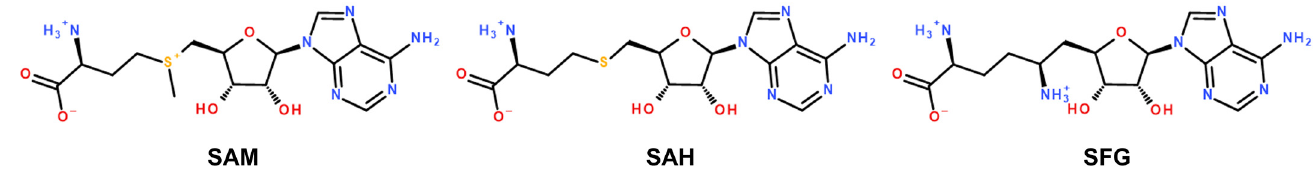
Figure 1. Molecular structures of the DNMT2 and NSUN6 cofactor SAM, the reaction product and auto-inhibitor SAH and the pan-methyltransferase inhibitor SFG.